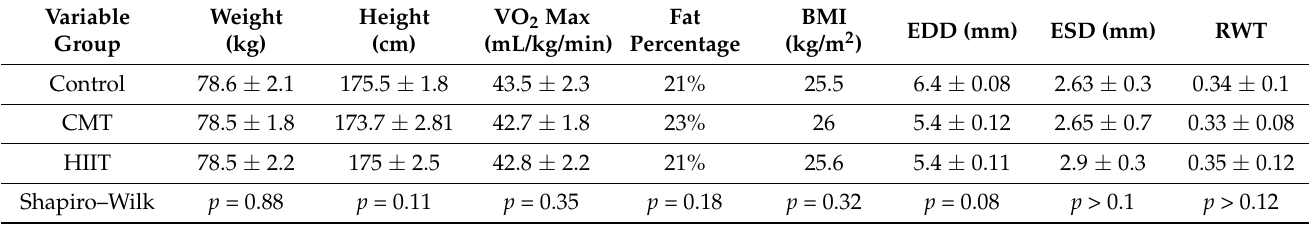
Table 2. Mean ± SD of Weight, Height, Body Fat Percentage, and Aerobic Power of Participants before